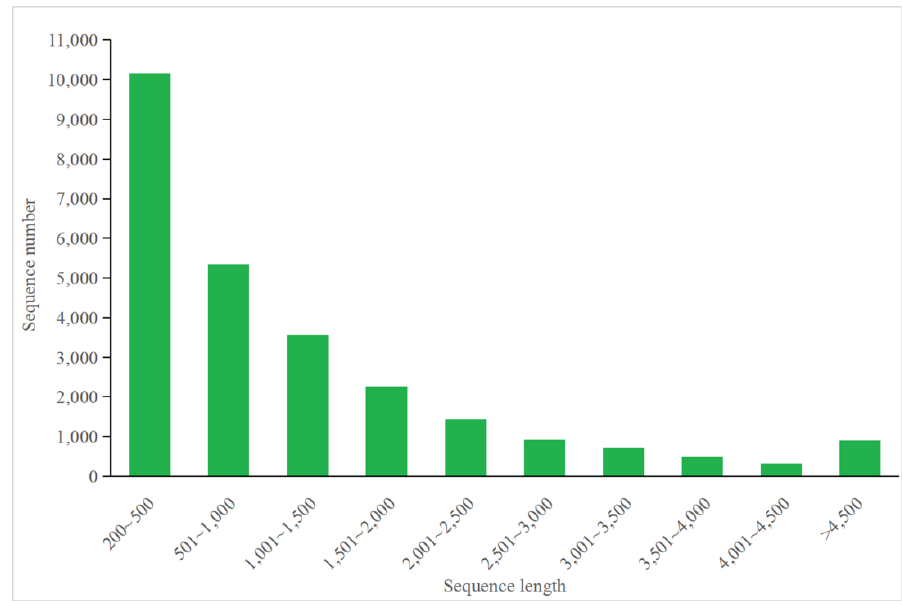
Figure 8. Length distribution of transcripts in C. fusiformis .